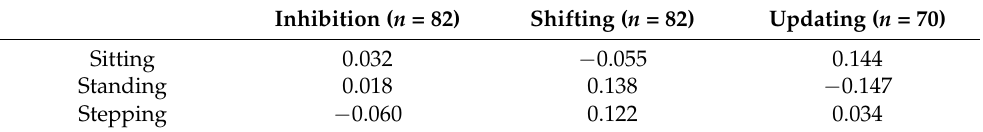
Table 3. Zero-order correlations between the PA/SB variables and the cognitive outcome